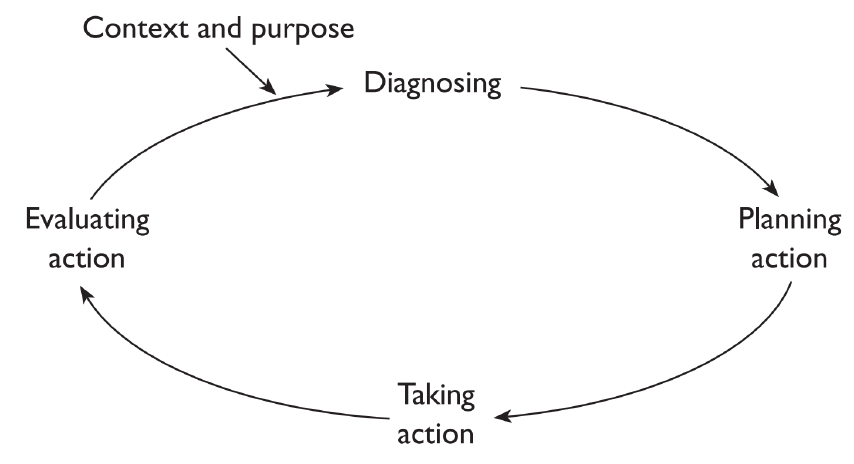
Figure 1. Action research process as outlined in [31]